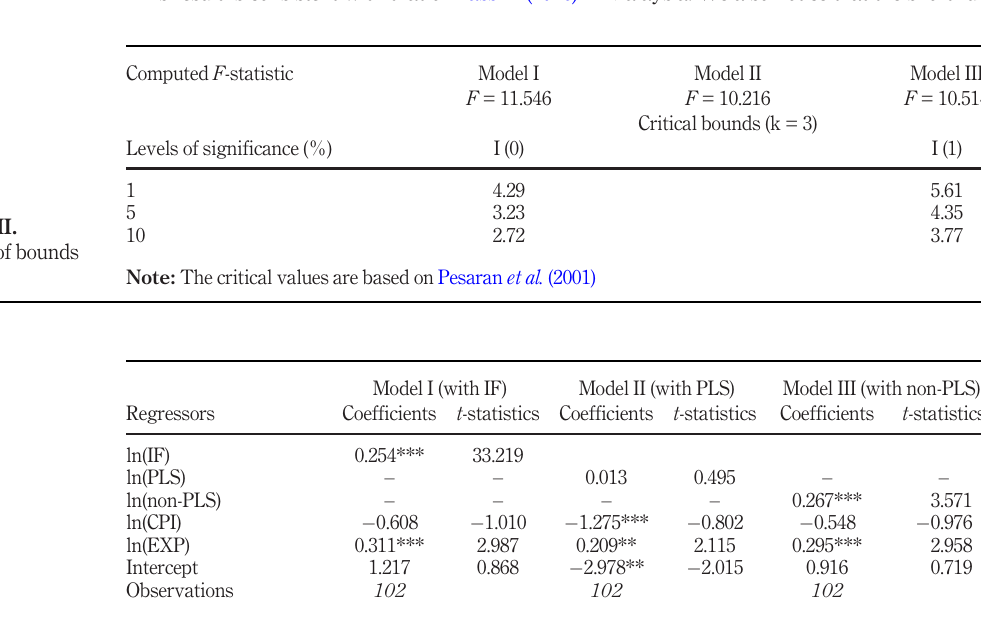
Table IV. ARDL estimates of long-run